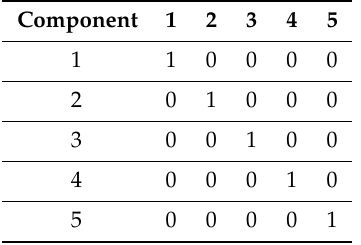
Table 3. Component Score Covariance Matrix (1. Stakeholder Involvement; 2. Research Base; 3. Planning Consistency; 4. Policy Environment, and 5. Development of Plans /